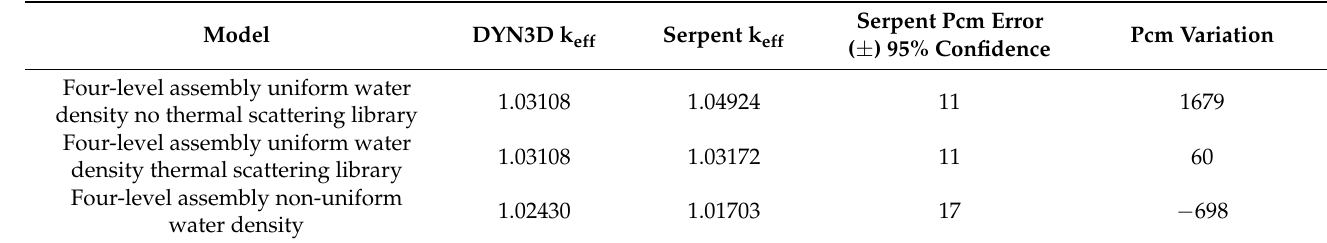
Figure 11. Pure neutronic axial power profile of DYN3D and Serpent. Serpent’s power profile is averaged across each pin within the axial node. Table 4. Four leveled fuel assembly reactivity coefficients comparison.